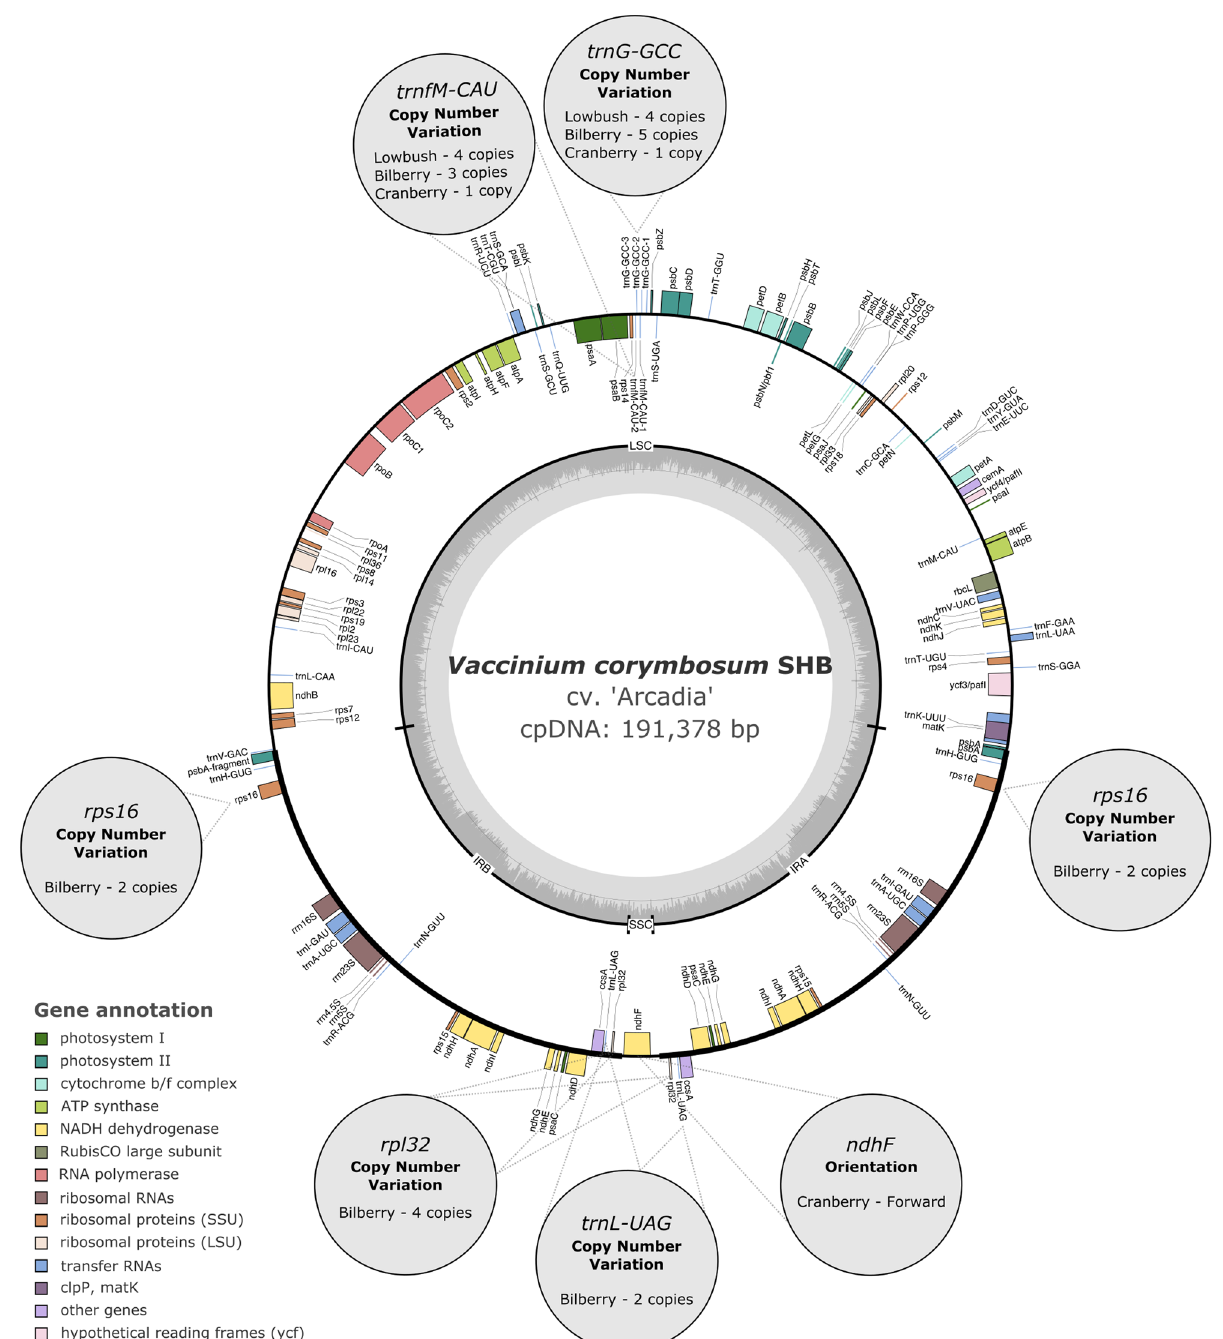
Figure 1. Circular chloroplast genome map of southern highbush blueberry cv. ‘Arcadia’ ( V. corymbosum hybrids). Outer gray bubbles indicate the variable annotation features among the six Vaccinium assemblies. Genes drawn outside and inside the map represent genes transcribed counterclockwise and clockwise, respectively, and the different colors represent their functional annotation. The large single copy (LSC), inverted repeats (IRA and IRB), and small single copy (SSC) regions are shown in the black inner circle. The gray inner circle shows GC